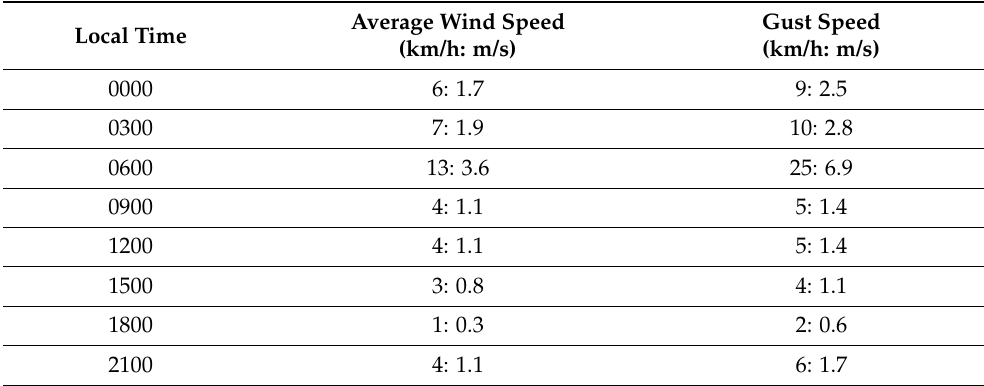
Table 2. Historical weather data from for 3 October 2013, for Weno Island, Chuuk Lagoon, from World Weather Online (https://www.worldweatheronline.com/weno-weather-history/chuuk/fm.aspx accessed on 26 August 2022). The period of low windspeed indicated by the MERRA-2 surface maximum windspeed data is supported by these observations, where the windspeed is shown as 1 km/h (0.3 m/s) with gust speed to 2 km/h (0.6 m/s) at 1800 local time. Average Wind Speed Gust Speed Local Time (km/h: m/s) (km/h: